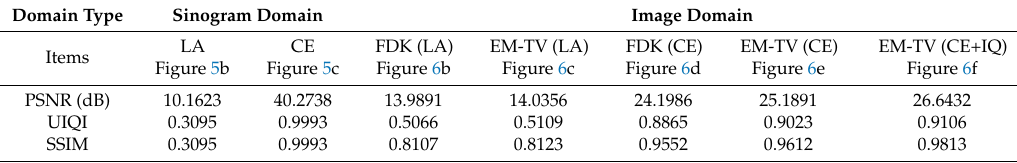
Figures-of-merit for limited angle sinogram completion in sinogram and image domain